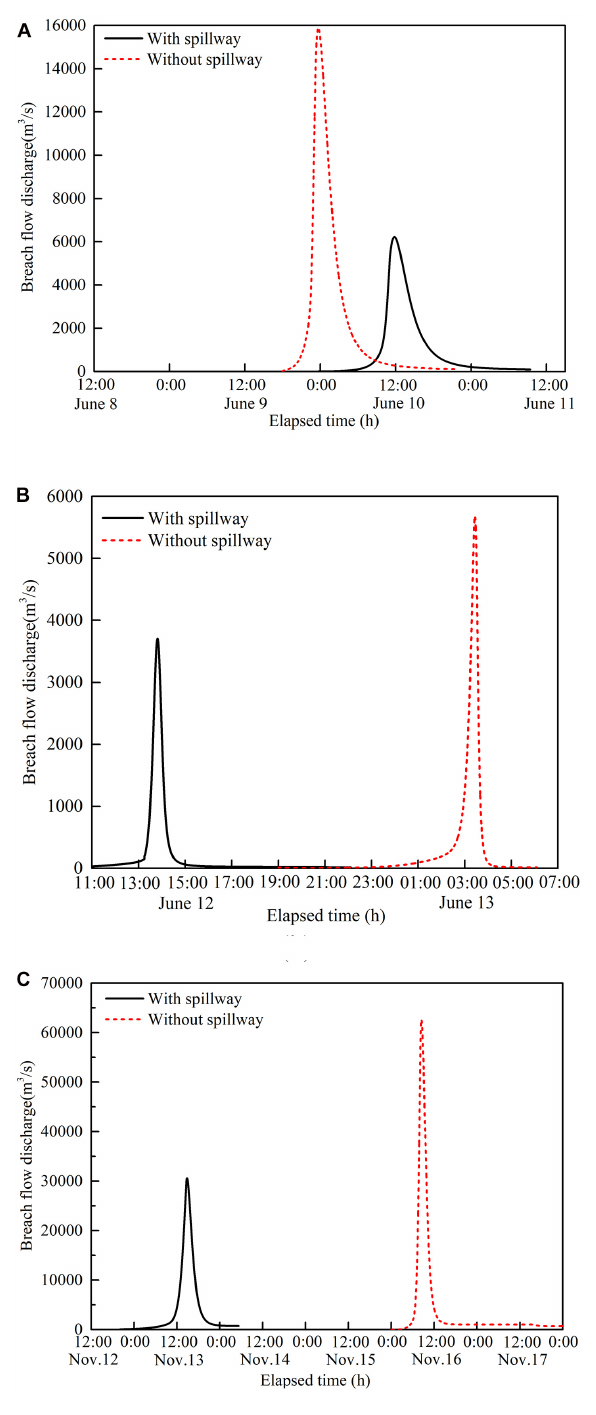
large boulders are washed away, the erosion speed accelerates, and the final peak breach flow charge increases, which is also very harmful.